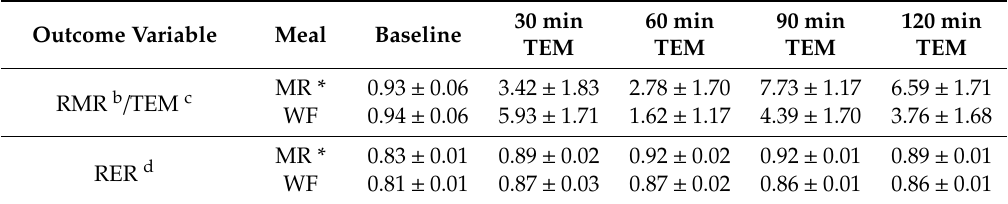
Table 4. RMR, TEM, and RER during the test meals a .